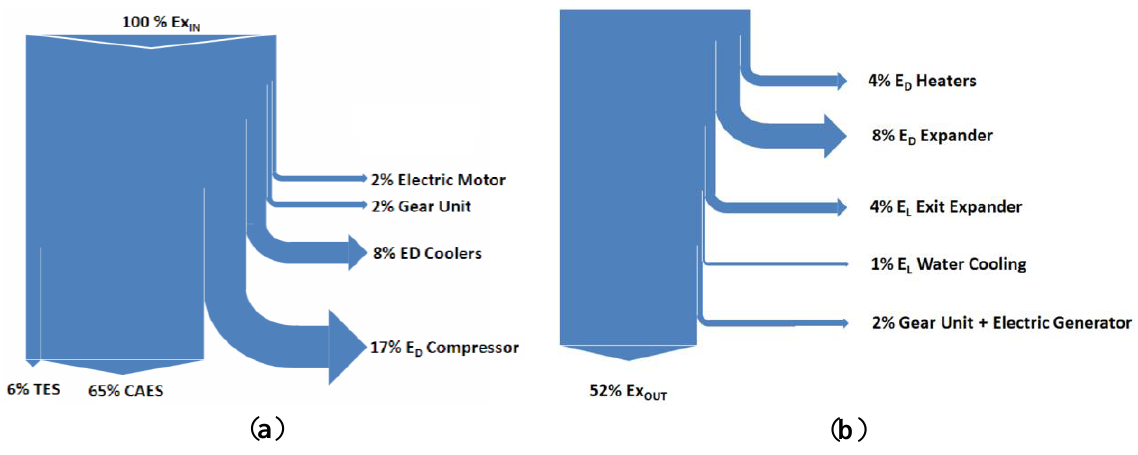
Figure 12. Sankey diagram of exergy flow. ( a ) Charging; ( b ) Discharging.